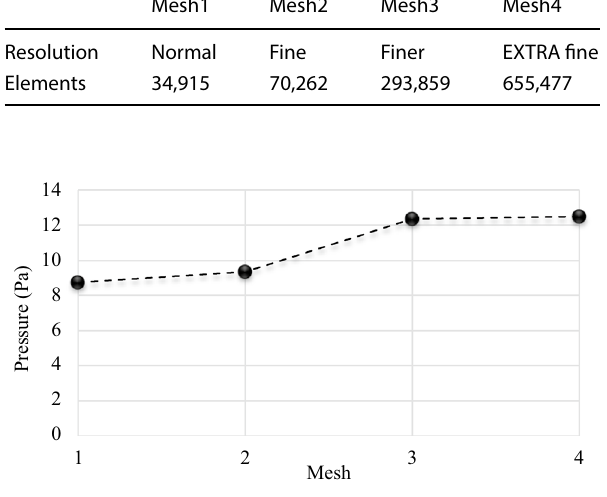
Fig. 6 Mesh convergence plot of the pressure